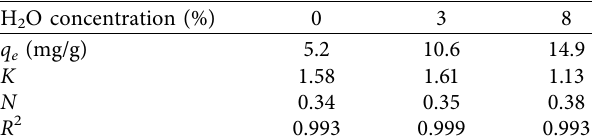
Table 6: The parameters of Bangham model of Figure 9(b). H 2 O concentration